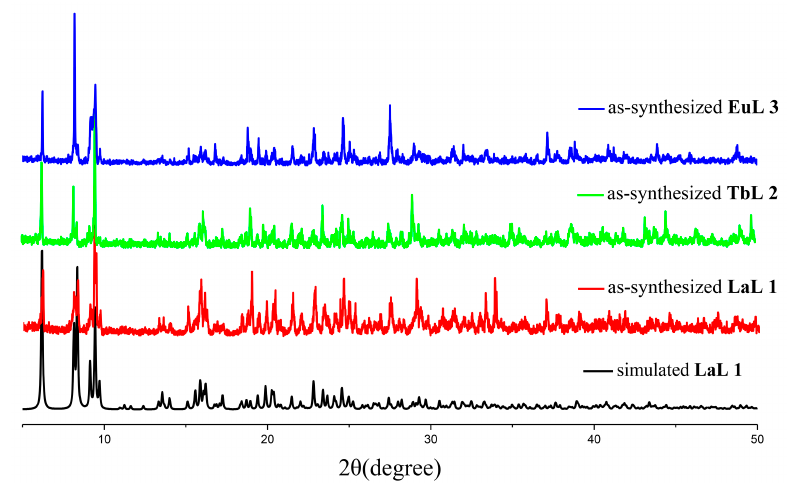
Figure 2. The PXRD patterns of LaL 1 , TbL 2 , EuL 3 .